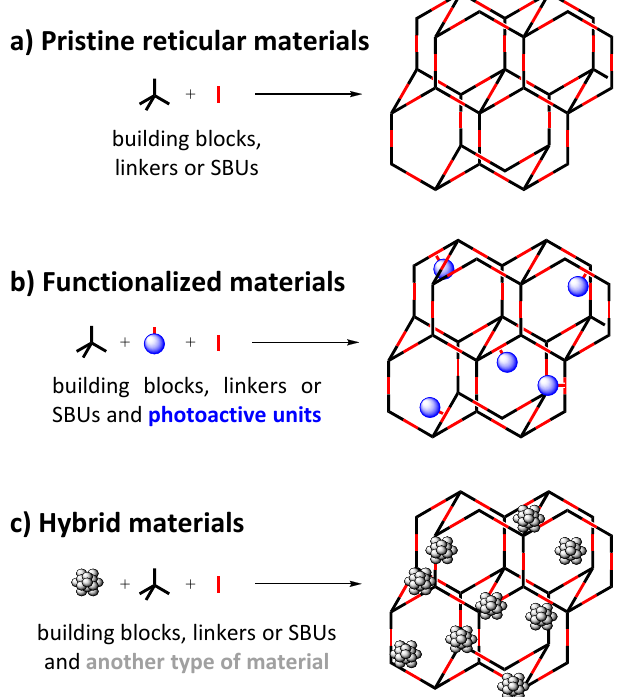
Scheme 1. Graphical representation of the three different strategies applied in the design of photoactive MOFs and COFs: a ) Pristine reticular materials. b ) Functionalized materials. c ) Hybrid